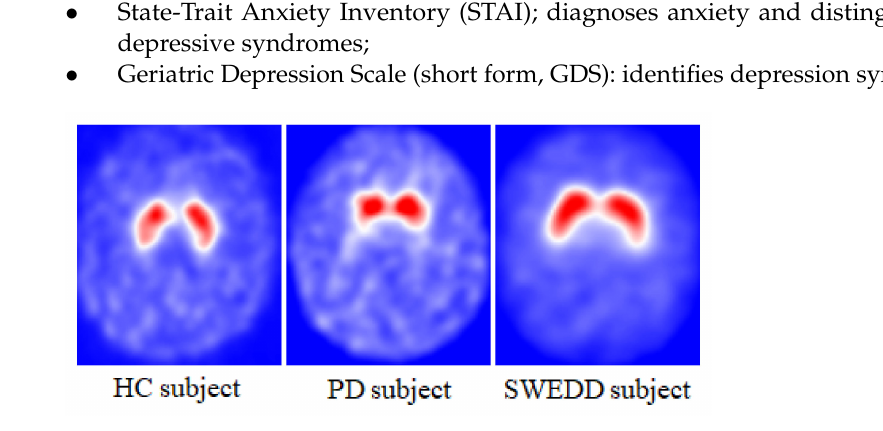
Figure 2. DaTSCAN SPECT imaging of the dopaminergic system for HC, PD and SWEDD